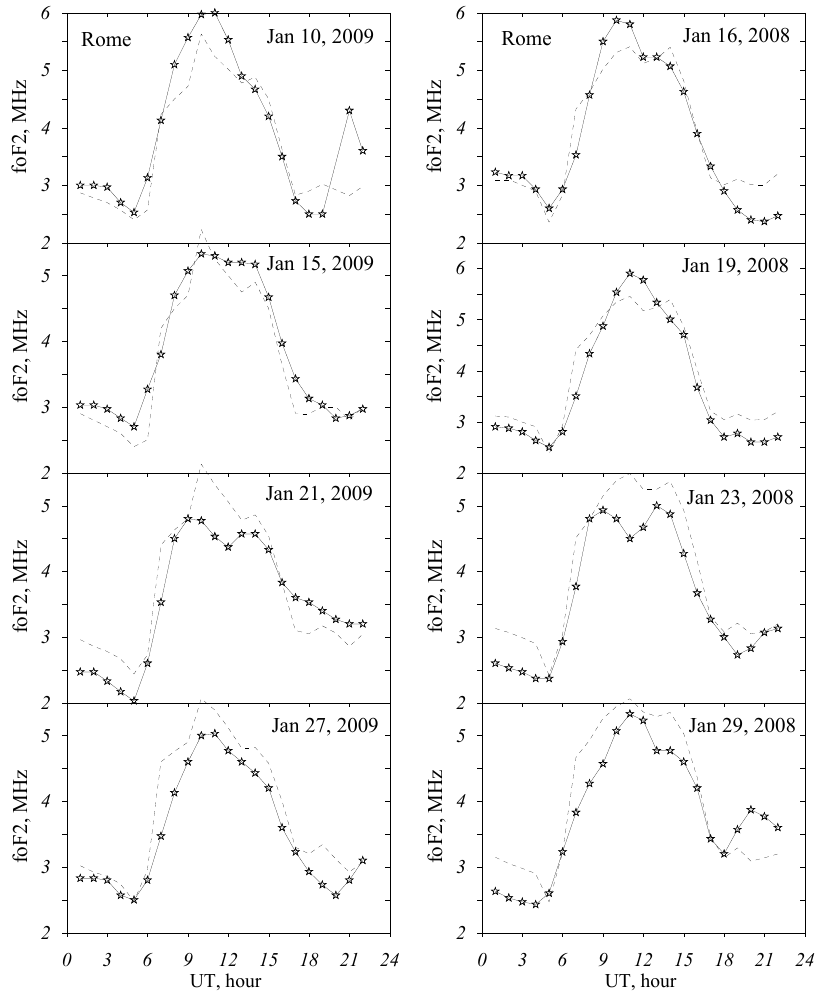
Figure 9. Observed averaged over (11–13) LT f o F 2 variations (asterisks) in a comparison with model monthly medians (dashes) at Rome for the events of SSW 2009 and 2008.